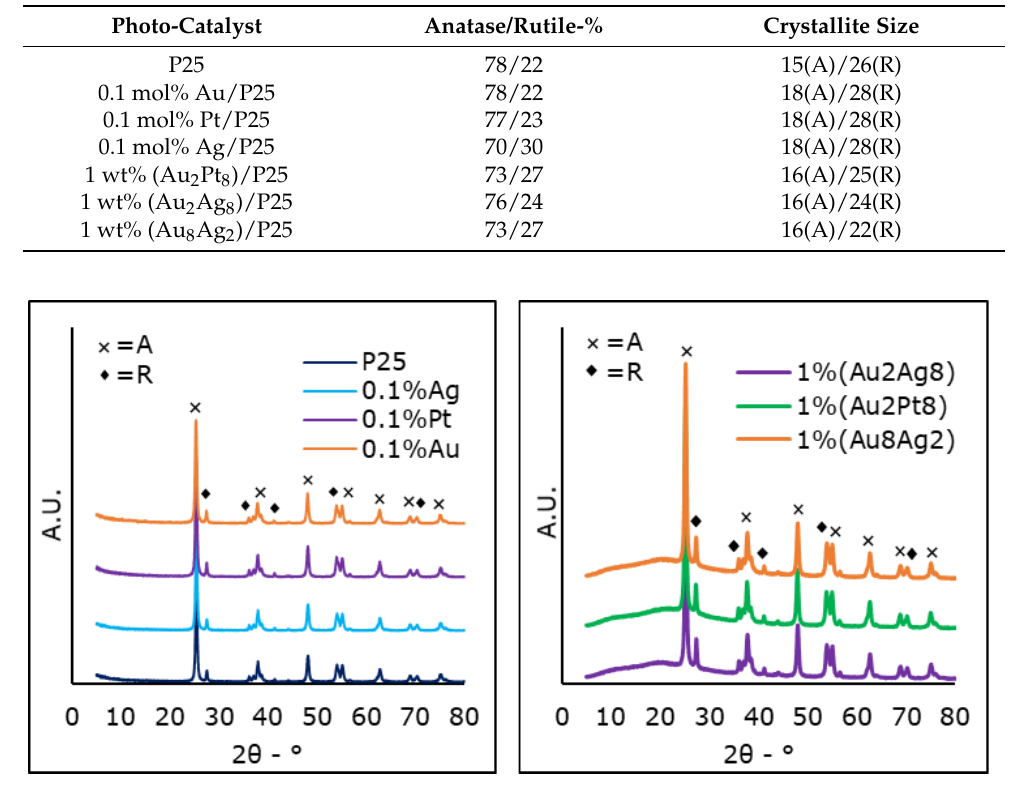
Table 4. XRD analysis results of mono and bi-metallic photocatalysts.